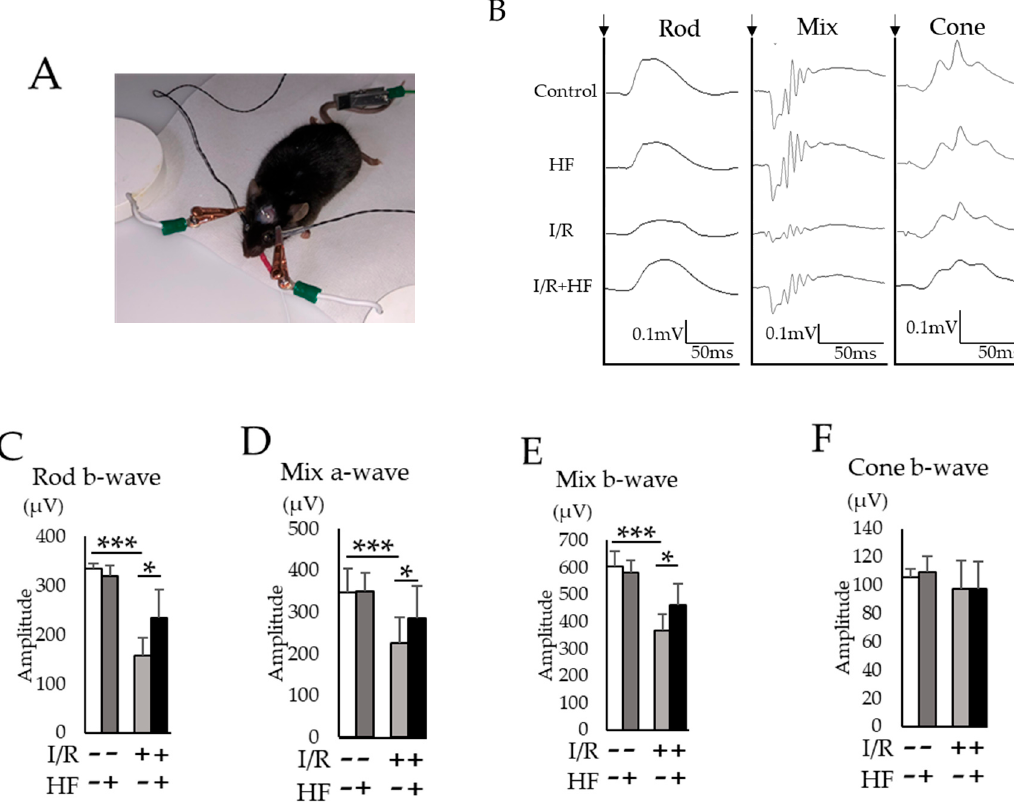
Figure 6. Retinal function evaluated with electroretinography (ERG). ( A ) A representative photograph of ERG recording. ( B ) Representative ERG waveforms for rod, mix, and cone conditions. Black arrows indicated the timing of the light stimulation. The averaged amplitudes were shown for rod b-wave ( C ), mixed a-wave ( D ), mixed b-wave ( E ), and cone b-wave ( F ) ( n = 3–6). Note that decreased amplitudes in rod and mix conditions were suppressed by harofuginone administration. Error bars indicate the standard deviation. HF; halofuginone. * p < 0.05, *** p < 0.001, Student’s t -test.